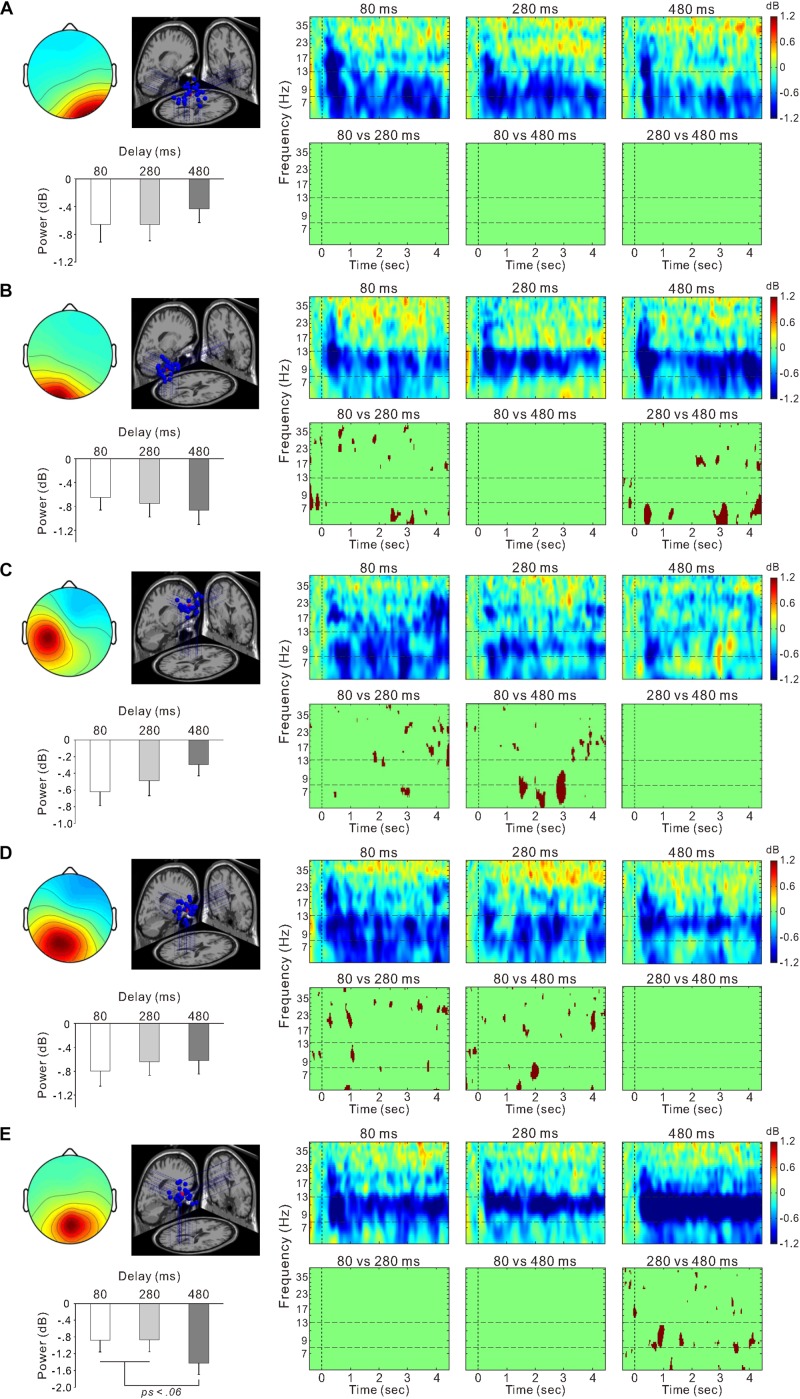
Scalp topographical map, dipole locations, ERSP time-frequency plot, and statistically significant differences in time-frequency plots and mean power within the 8–13 Hz frequency range for the right occipital cluster (A), left occipital cluster (B), left sensorimotor cluster (C), posterior cingulate cluster (D), and parietal cluster (E).